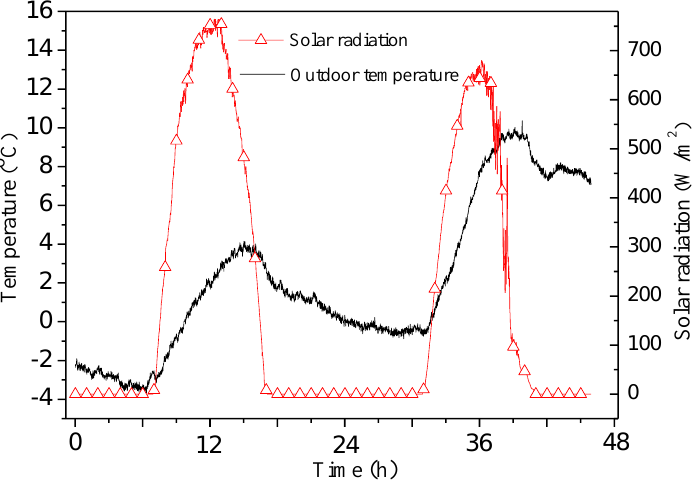
Figure 5. Solar radiation intensity and outdoor air temperature on 18 and 19 January.